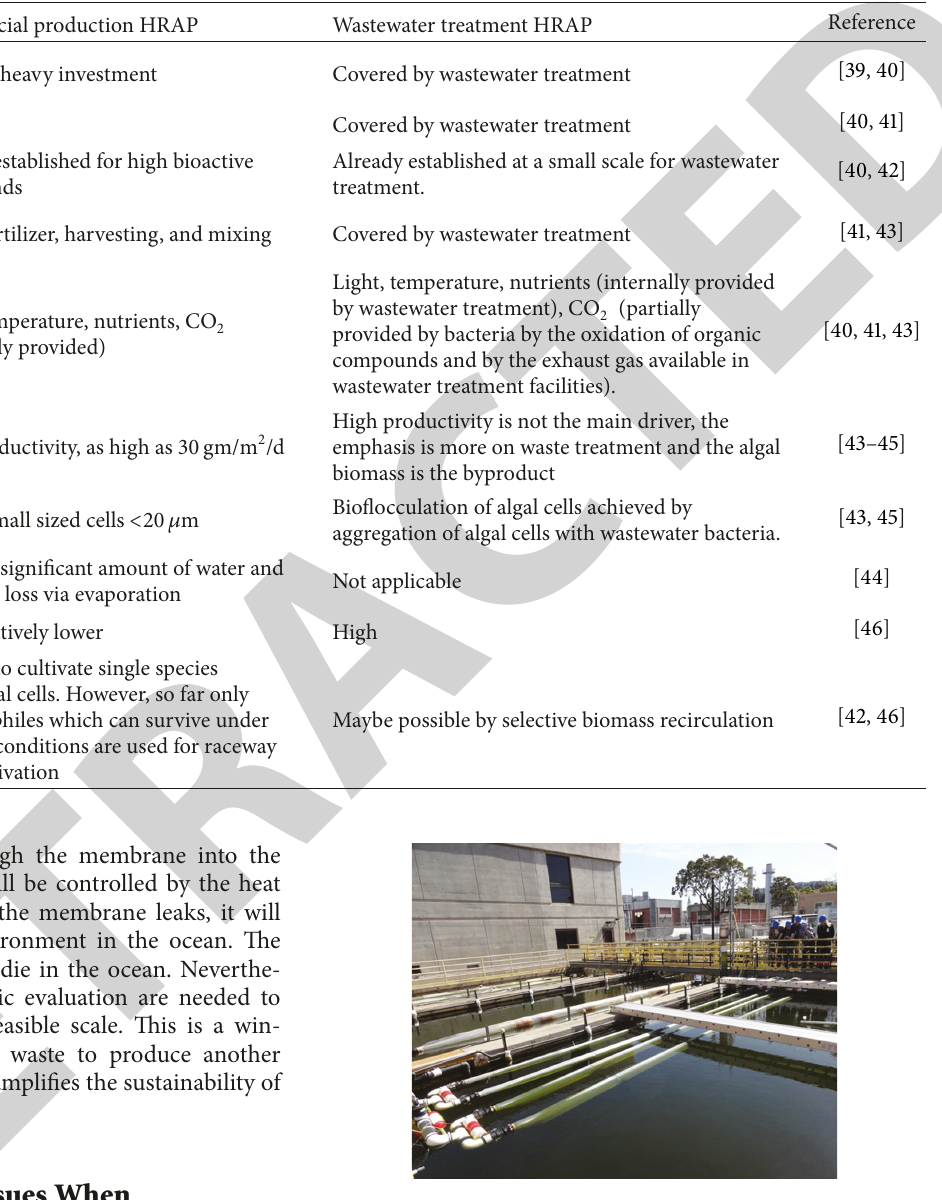
Figure 3: NASA OMEGA prototype